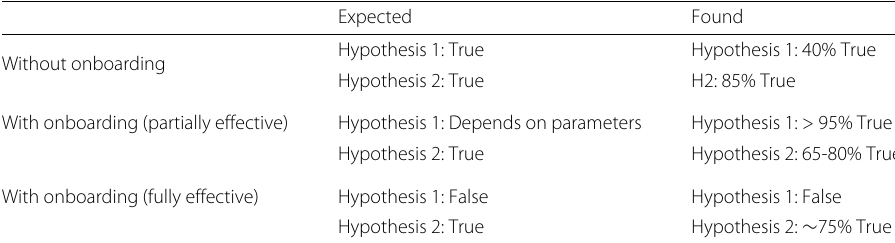
Table 2 Testing for Hypotheses 1 and 2: expectations as declared in “The simulation model” section vs.